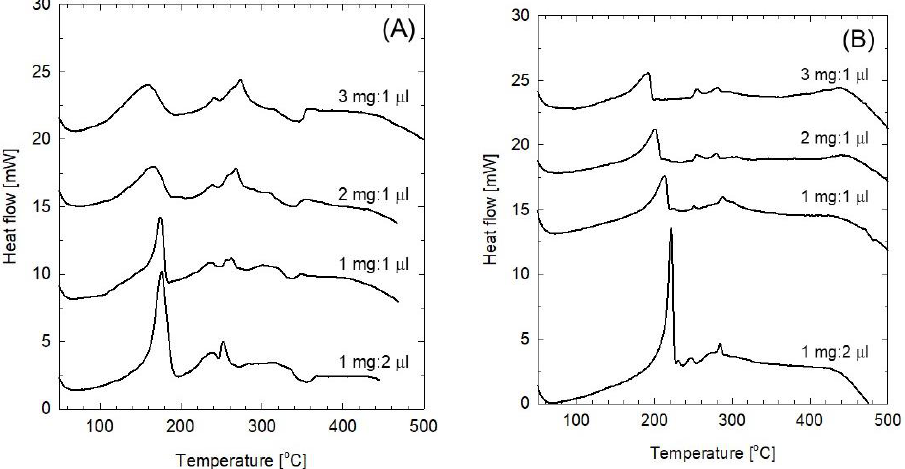
Figure 5. DSC curves of the mixture of the ( A ) lithiated FeOF and ( B ) delithiated FeOF electrode and 1 mol dm ´ 3 LiClO 4 /PC solution at different electrode/electrolyte ratios.